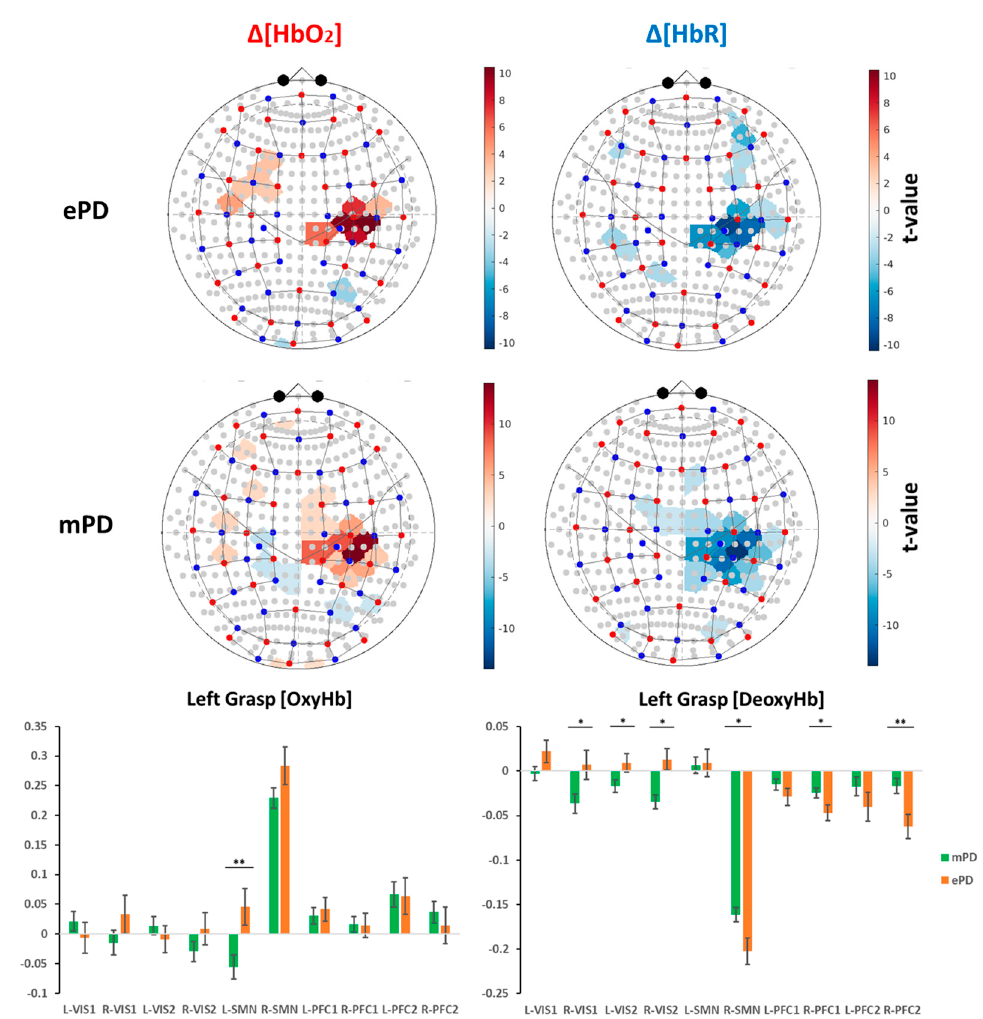
Figure 2. ( Top ) Significant group-level activation maps referring to left-grasp task. Results were corrected for multiple comparisons ( p FDR < 0.05). ( Bottom ) ROI analysis of group-level left-grasp task for the ePD and mPD groups: (*) significant contrasts not corrected for multiple comparisons ( p < 0.05); (**) significant contrasts corrected for multiple comparisons ( p FDR < 0.05). The correspondence between ROIs (i.e., horizontal axis) with functional and anatomical cortical areas is reported in Section 4.6.